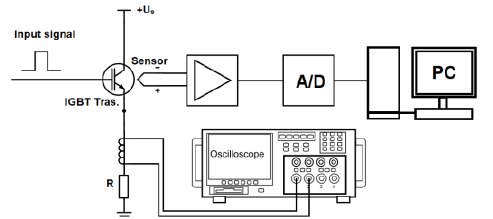
Fig. 1. Diagram of a measured system for testing acoustic emission phenomena in an IGBT transistor.